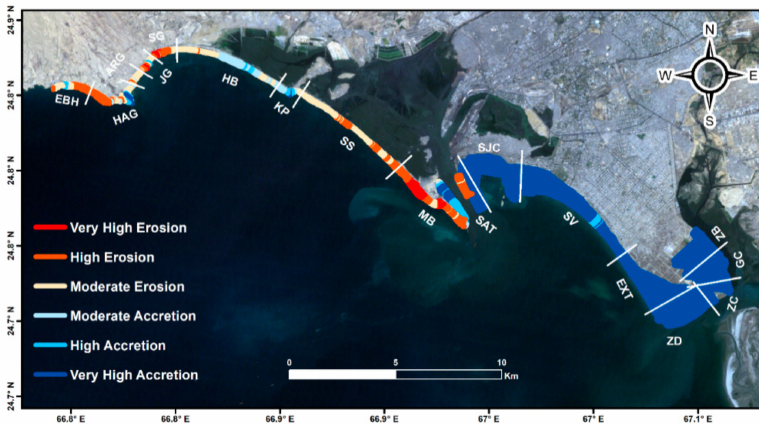
Figure 9. Shoreline vulnerability map of the study area (the width indicating the spatial extent of the overall shoreline development) (DHA = Defense housing Authority; ZB = Zone B; GC = Golf Club; ZC = Zone C; Ext = Extension, SV = Sea-view, SJC = Shireen Jinnah Colony, SAT = South Asian Terminal, MB = Manora Beach, SS = Sandspit, KK = Kaka Pir, HB = Hawks Bay, JG = Jamali Goath, SG = Somar Goath, ARG = Abdul Rehman Goath, HAJ = Haji Ali Goath, and EBH = Engro Beach